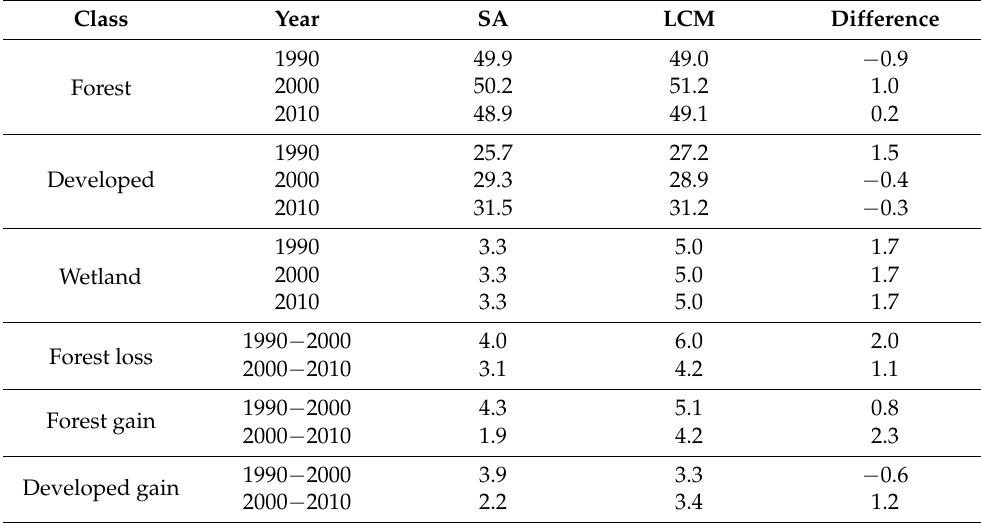
Table 4. Estimated percent area of land cover and land cover change obtained using SA compared to LCM for reference data from all seven